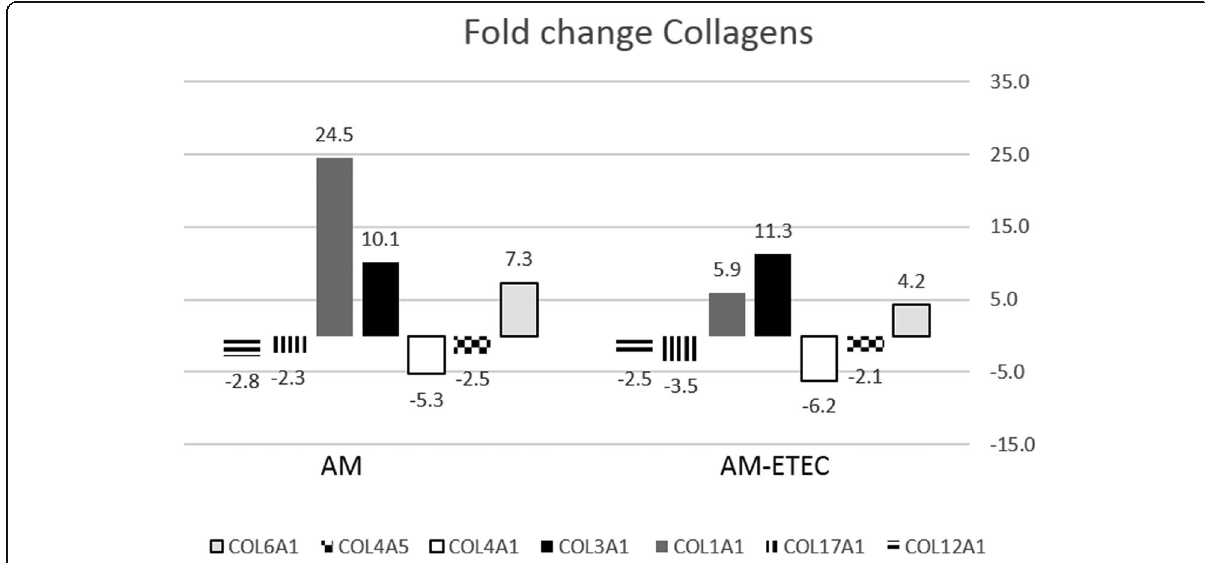
Fig. 3 Gene expression pattern of collagen variants in IPEC-J2 cells in response to the AM extract, with and without